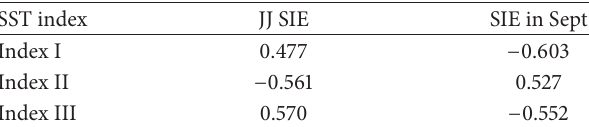
Table 2: The list of correlation relations between SST indices and the JJ SIE or SIE in September for 1979–2012. Note: Index I is SST averaged in 30 ∘ –50 ∘ N, 160 ∘ E–160 ∘ W, Index II is SST averaged in 20 ∘ – 30 ∘ N, 120 ∘ –150 ∘ W, and Index III is SST averaged in 25 ∘ –35 ∘ N, 20 ∘ – 45 ∘ W. The 99% confidence level is